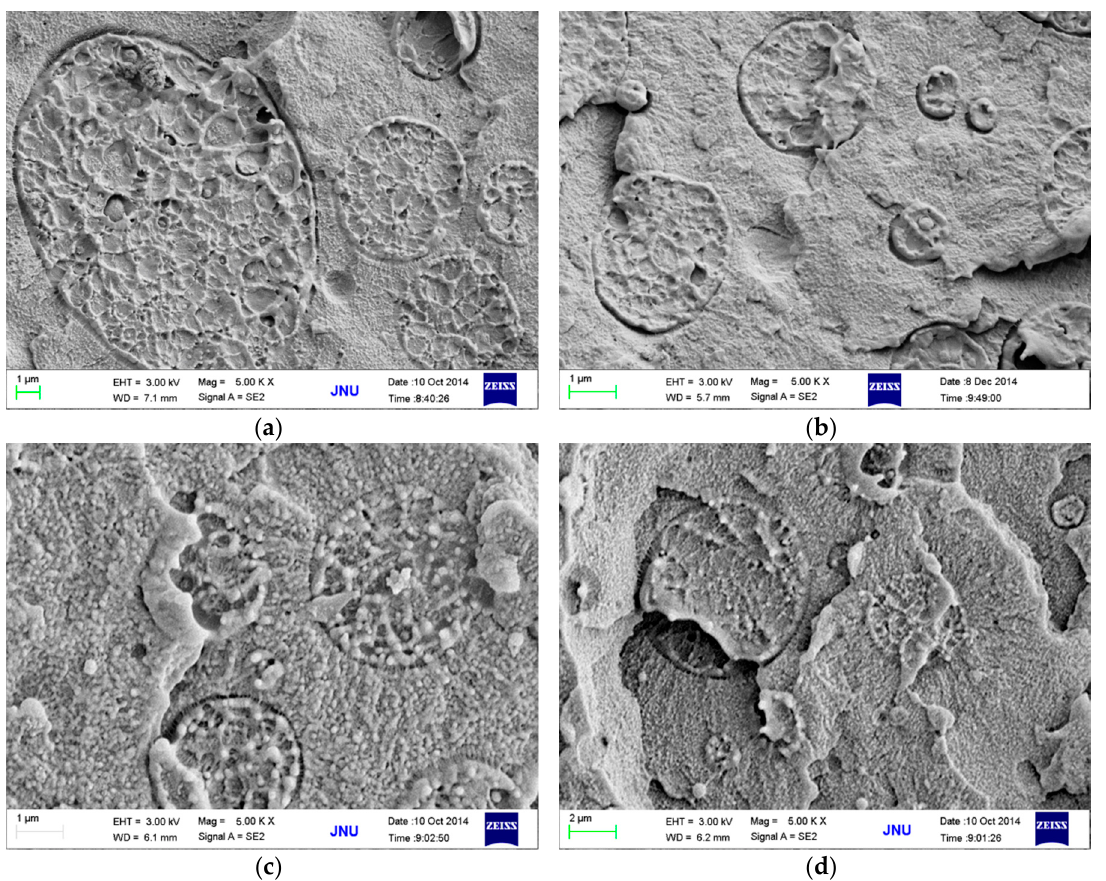
Figure 8. SEM micrographs of samples molded for once ( a ), three times ( b ), six times ( c ), and seven times ( d ).